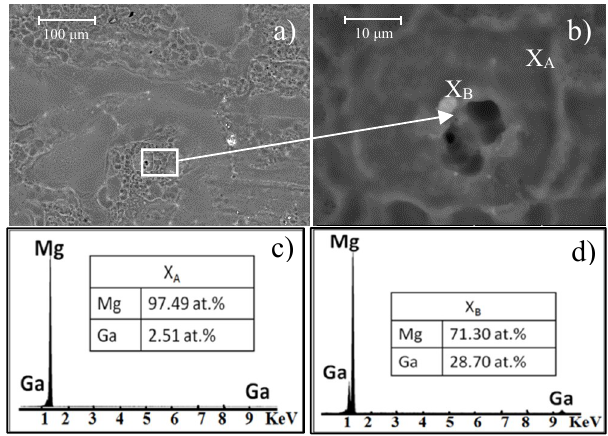
Figure 11. SEM images of the topography of ( a ) as-cast Mg-0.375Ga after 504 h of immersion in SBF, ( b ) a detail of pitting adjacent to Mg 5 Ga 2 precipitate, ( c ) EDS analysis of X A zone, ( d ) EDS analysis of X B zone.